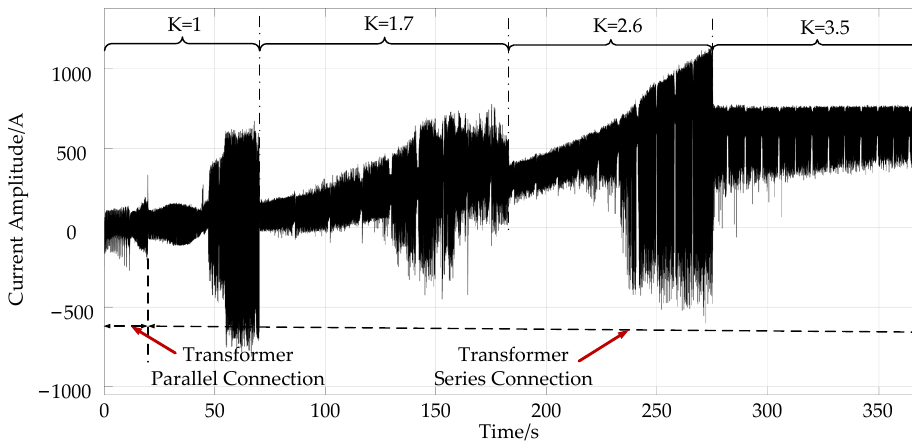
Figure 19. The q -axis output current of the converter at the end points.